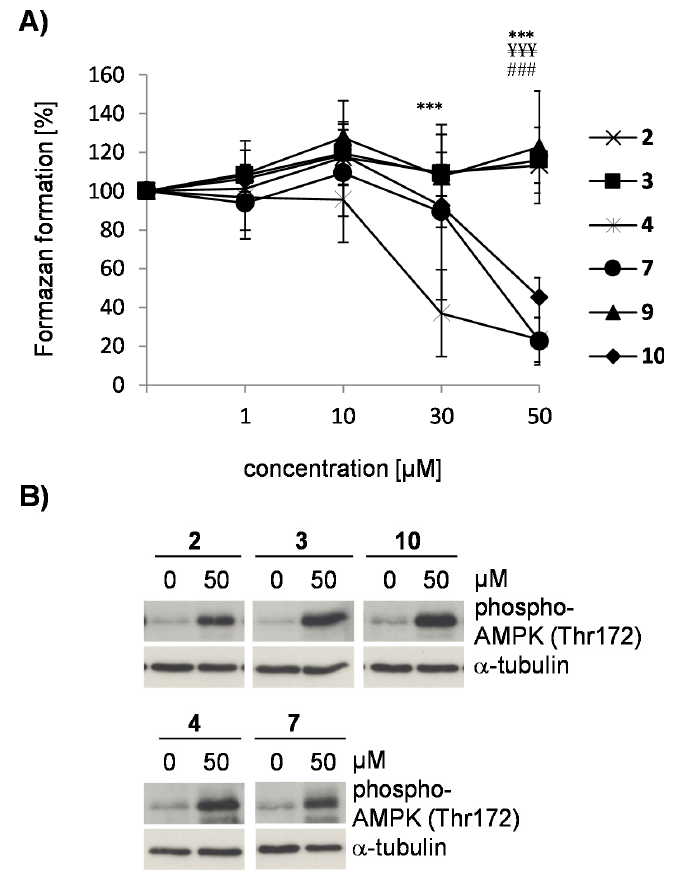
Figure 3. Effect of flavonoids 2 , 3 , 4 , 7 , 9 , and 10 on cellular metabolism. In ( A ), an MTT cell